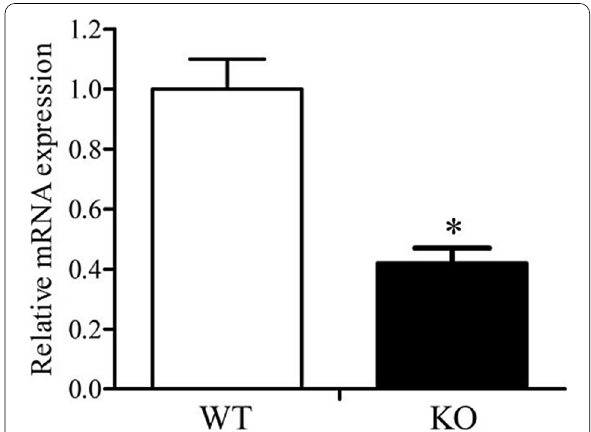
Fig. 3 Growth kinetics of WT and cofD KO strains of M. ruminantium grown in BJ medium at 39 ℃ (n 3). Growth was determined by = measuring the absorbance of the cultures at 600 nm. WT